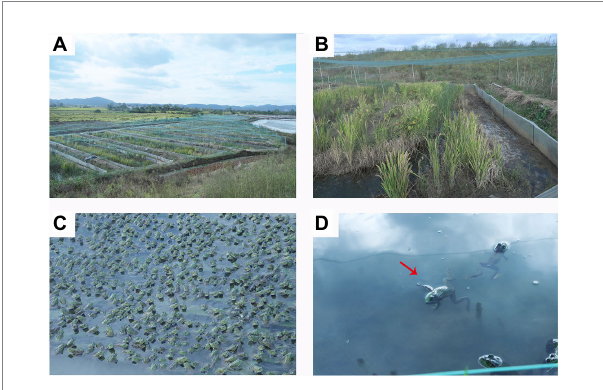
FIGURE 1 Morphology of the healthy and diseased bullfrogs ( Lithobates catesbeiana ). (A,B) Farm environment. (C) Breeding density; (D) Morphology of diseased (meningitis-like infectious disease, which causes muscle relaxation in sick frogs) frog morphology (red